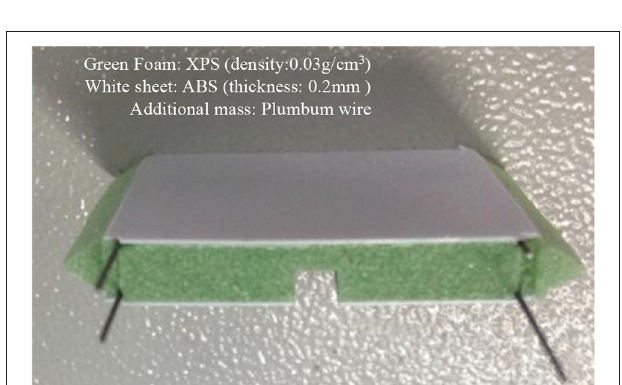
FIGURE 11 | Transition at